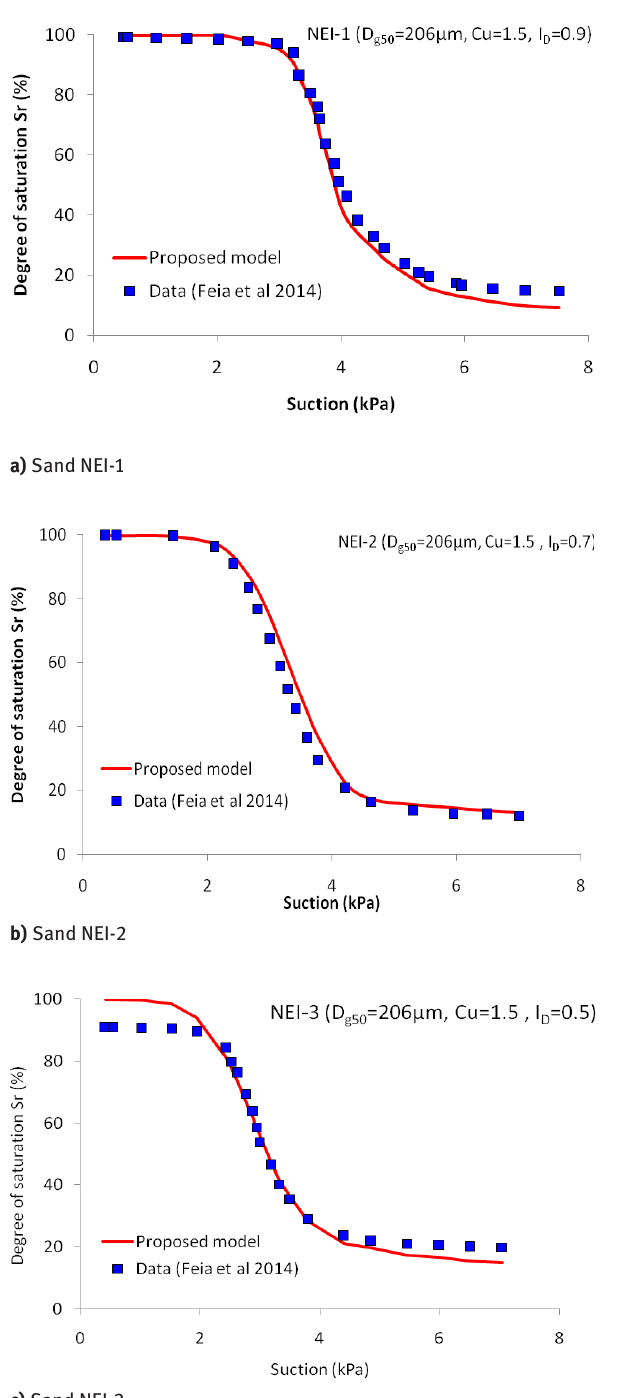
Figure 8: Calibration of the model on the basis of the experimental data for a) Sand NEI-1, b) Sand NEI-2, and c) Sand NEI-3